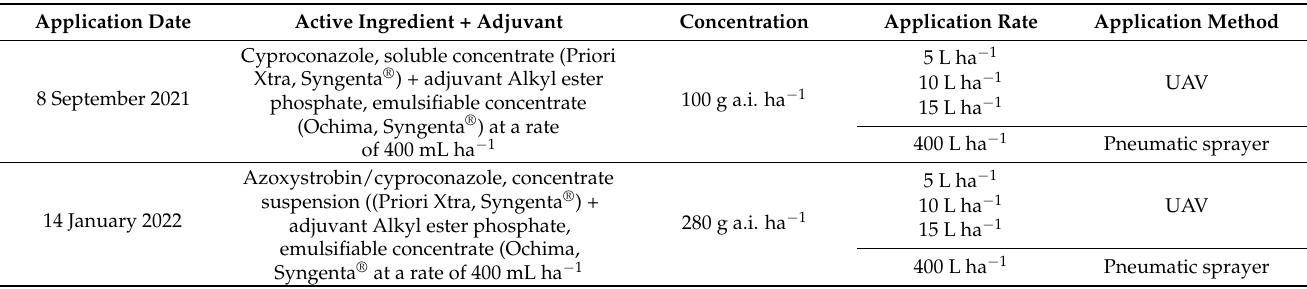
Table 4. Active ingredients for the prevention and control of leaf rust and cercosporiosis in coffee plants, application date, concentration, application rate, and application method.